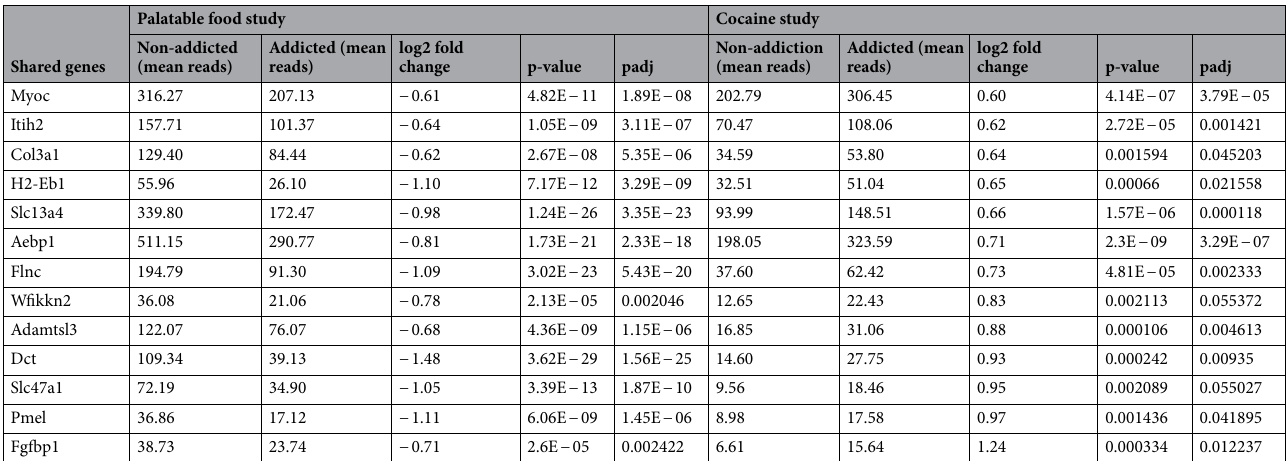
Table 2. List of shared genes downregulated in food addicted mice and upregulated in cocaine addicted mice.